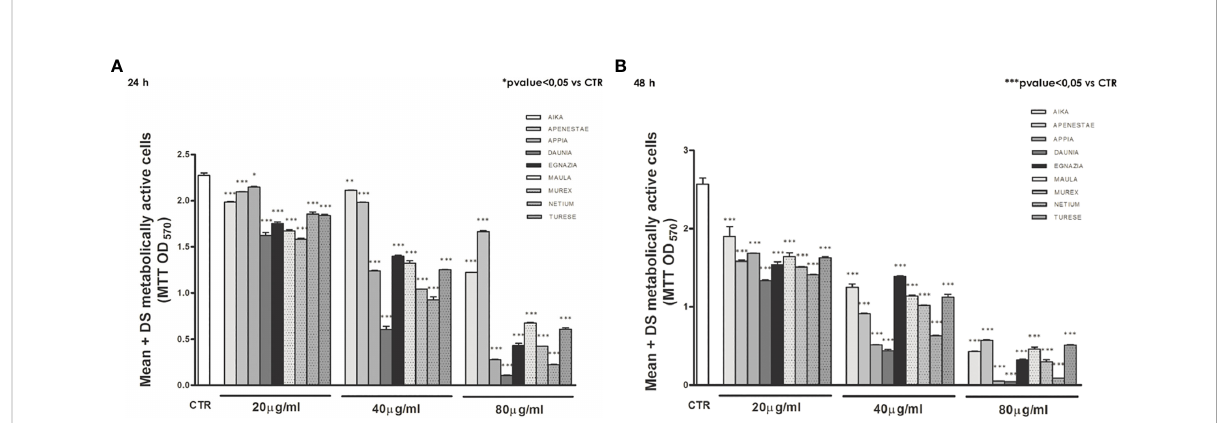
FIGURE 2 The antiproliferative effects of polyphenols of the nine GSEs on Caco2 cell proliferation. Treated with increasing concentrations (20, 40, 80 m g/ mL), both after 24 (A) and 48 h (B) of treatment. Data were expressed as mean ± standard deviation. p-Value was determined by Paired T-test; * p < 0.05; *** p <